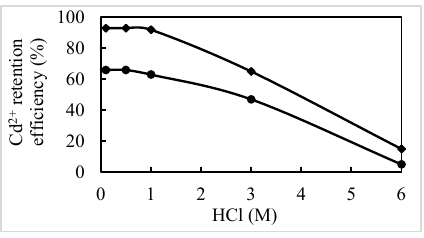
Figure 6. E ff ect of HCl concentration on Cd 2+ adsorption e ffi ciency on Br-resin (  ) and I-resin (  ). Figure 6. Effect of HCl concentration on Cd 2+ adsorption efficiency on Br-resin ( • ) and I-resin ( (cid:7)